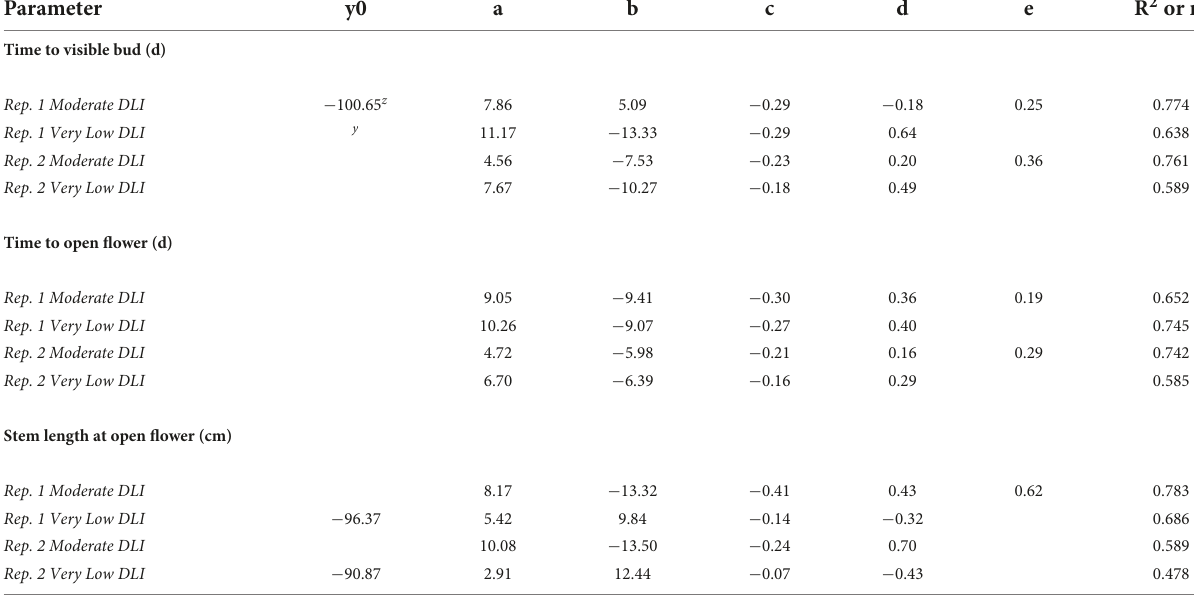
z Coefficientsformodelequationswereusedtogenerate Figure2 through Figure4 . y Blankcells=0. Allmodelsareintheformof:f=y0 + a ∗ YP + b ∗ FP + c ∗ YP 2 + d ∗ FP 2 + e ∗ (YP ∗ FP).